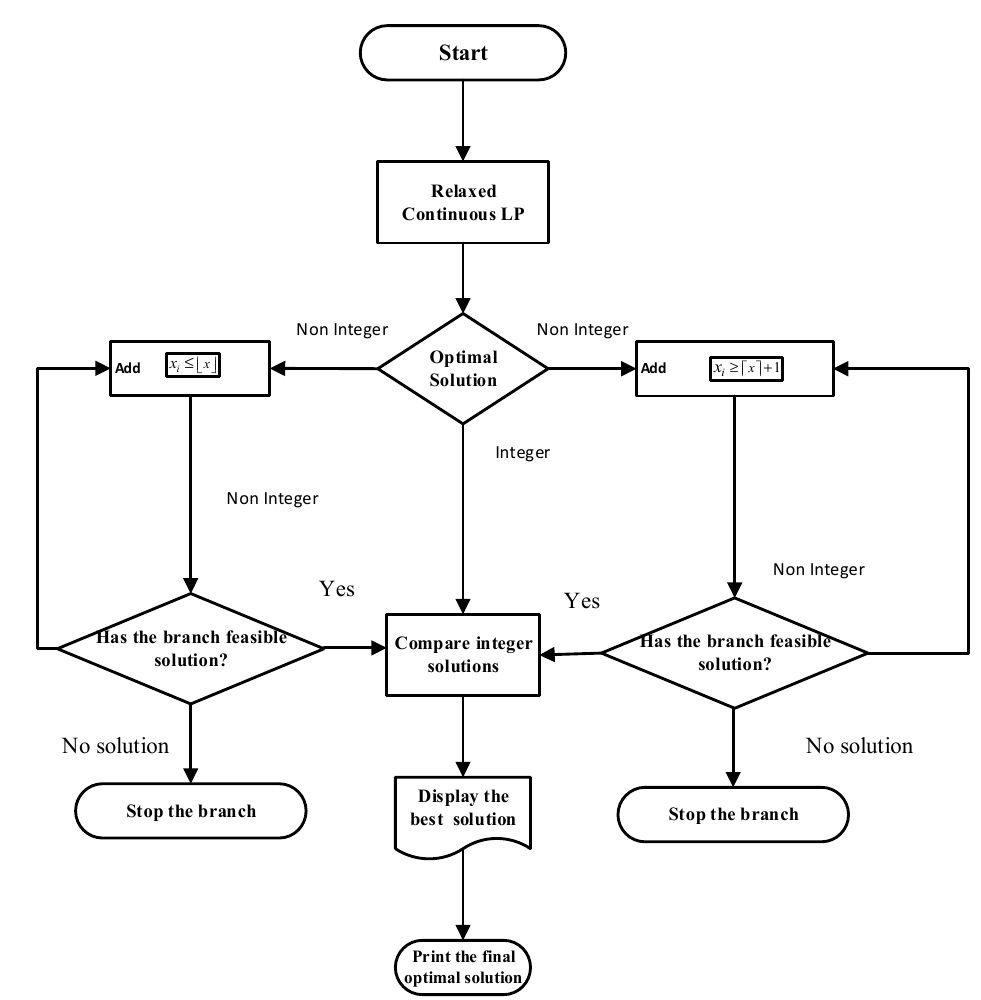
Figure 3. Flowchart of branch-and-bound method.